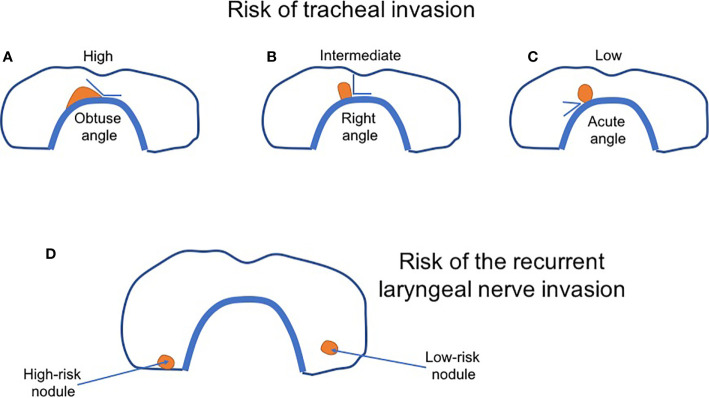
The scheme of sonographic classification of thyroid nodules based on the risk of tracheal and the recurrent laryngeal nerve invasion. (A–C) The risk of tracheal invasion depends on the angle between the nodule and tracheal wall. (A) High-risk nodule—an obtuse angle; (B) Intermediate-risk nodule—a right angle; (C) Low-risk nodule—an acute angle. (D) The risk of the laryngeal nerve invasion. Low-risk nodule (right) is surrounded by a thin of the normal thyroid. High-risk nodule (left)—no rim of the normal thyroid is observed. A nodule closely adheres to thyroid capsule and the nerve. The figure was modified by the authors based on Akira Miyauchi paper (67).